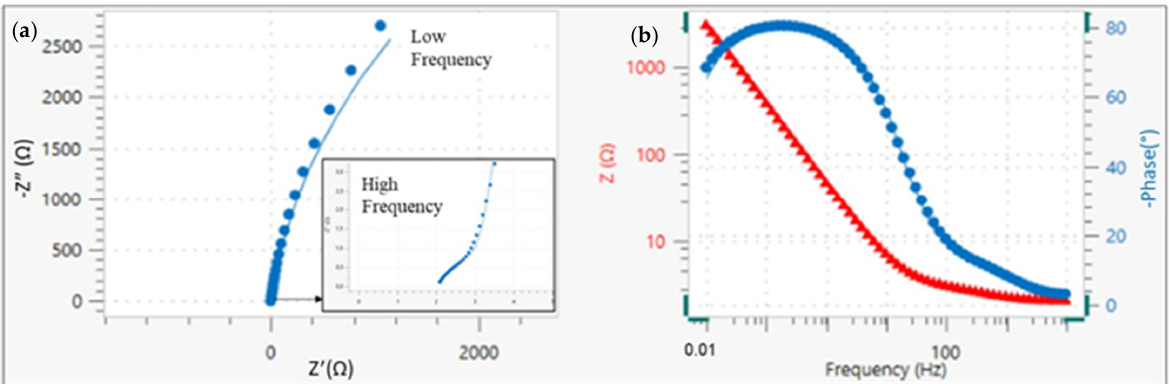
Figure 4. ( a ) EIS results with adjustment through equivalent circuit. ( b ) Nyquist and Bode diagram for Solution 1 at day 35.